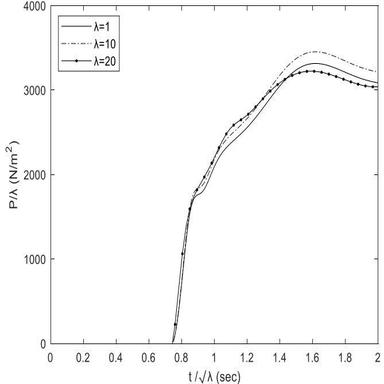
Normalised soil pressures (P) and duration of the impact by λ and ̅̅ λ √ respectively.